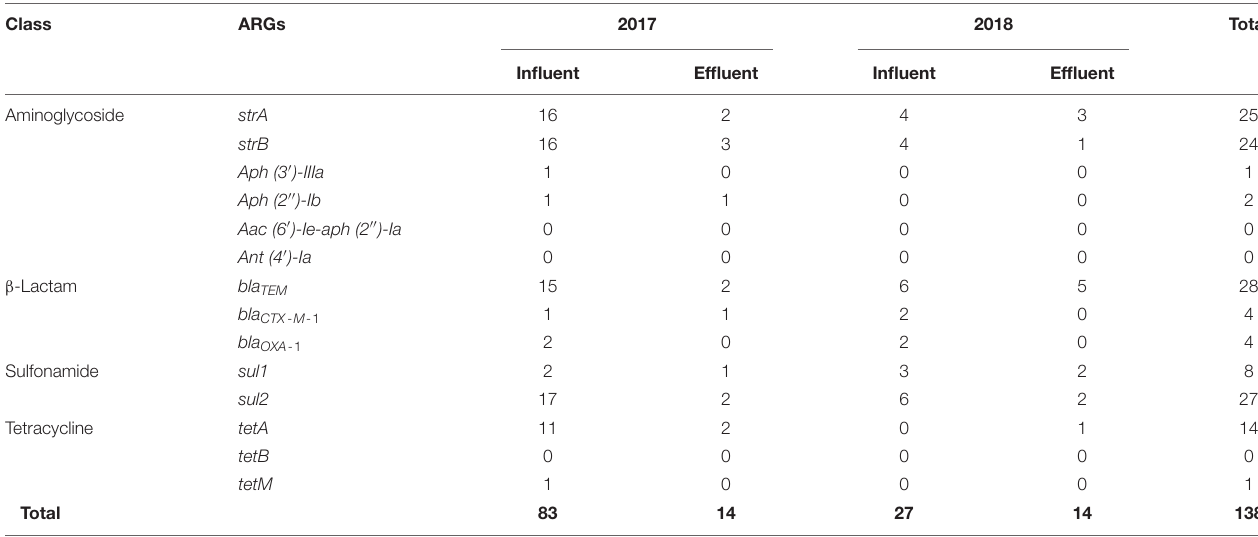
TABLE 3 | Detection of antibiotic resistance genes (ARGs) from multidrug-resistant bacteria at the influent and effluent in 2017 and 2018.